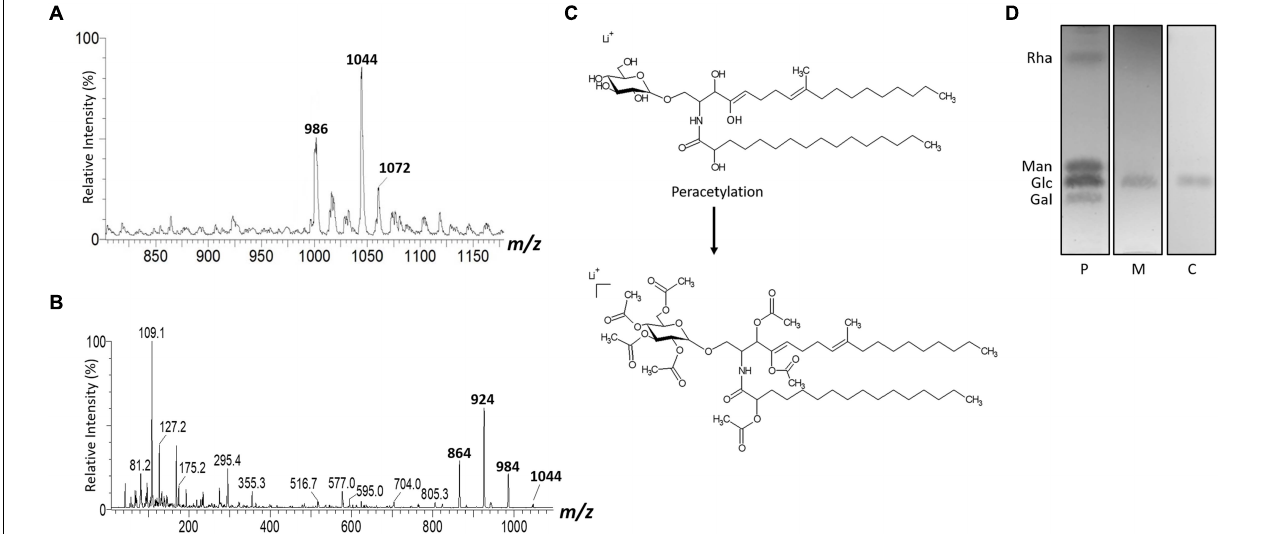
GlcCer species (200 µ g/mouse, i.p.) or only 0.5% DMSO in